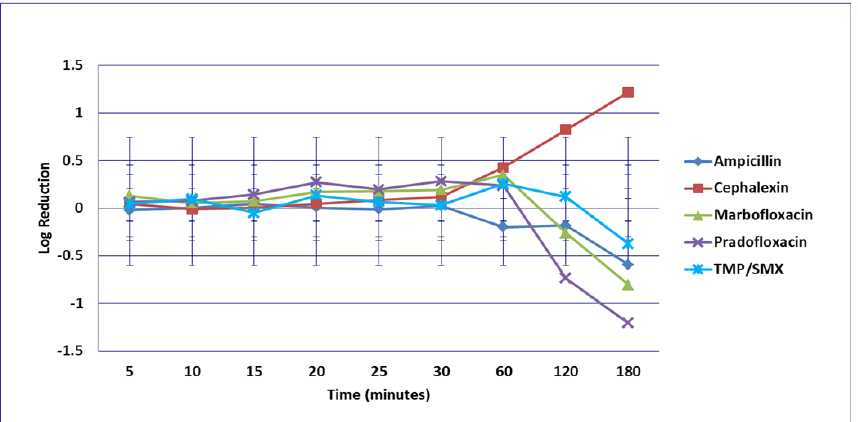
Figure 7. Log 10 reduction in E. faecalis with bacterial cells exposed to ampicillin, cephalexin, mar- bofloxacin, pradofloxacin, and trimethoprim/sulfamethoxazole at the maximum serum drug con- centration. Pradofloxacin vs. cephalexin at 120 and 180 min, p values <0.0001 for both comparisons. Marbofloxacin, TMP/SMX, and ampicillin versus cephalexin at 120 and 180 min, p value <0.0001 for all comparisons. Data points present mean ± standard deviation.